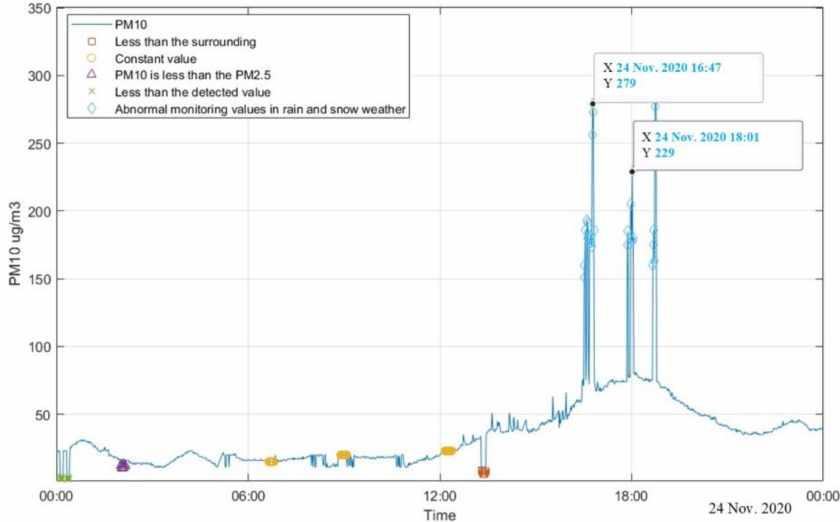
Figure 8. Identification of the PM10 monitoring value abnormal